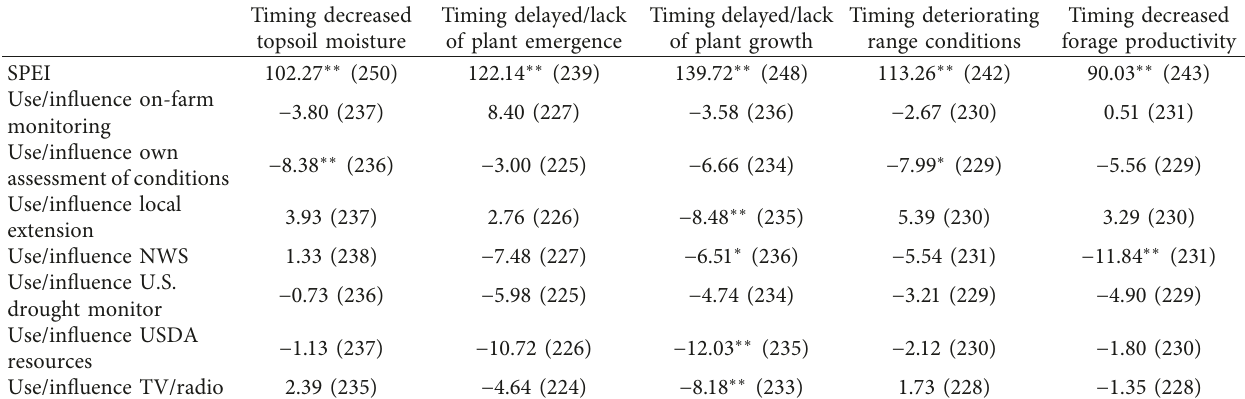
Table 3: Factors affecting the timing of observed